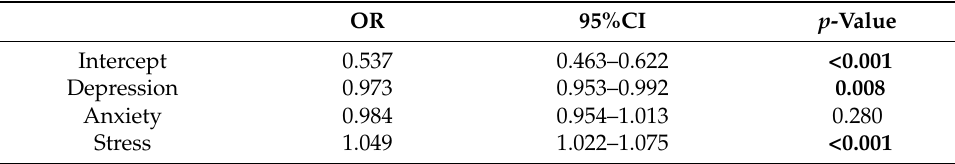
Table 5. The binary logistic regression model assessing the impact of DASS-21 parameters on the willingness to get vaccinated (total: healthcare workers and control group).